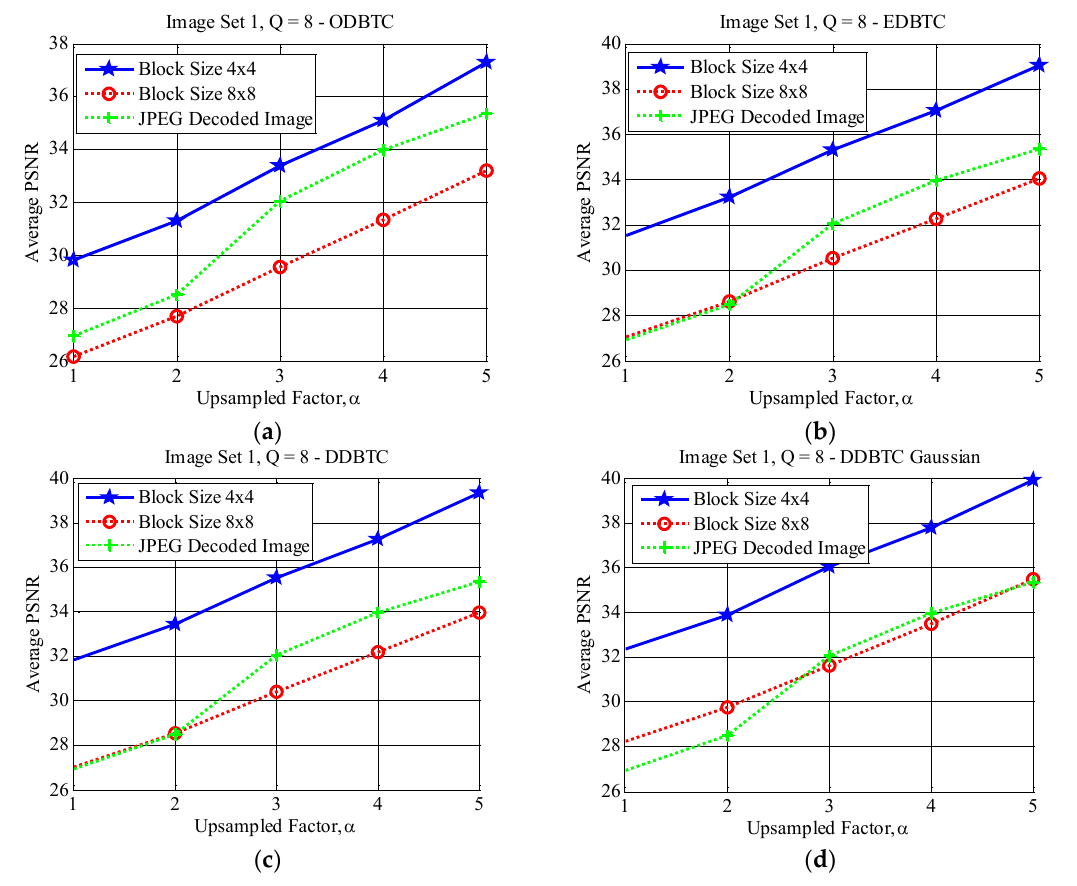
Figure 18. Effect of image block sizes on Image Set 1 with 𝑄 = 8 over ( a ) ODBTC; ( b ) EDBTC; ( c ) DDBTC; and ( d ) DDBTC Gaussian scheme.